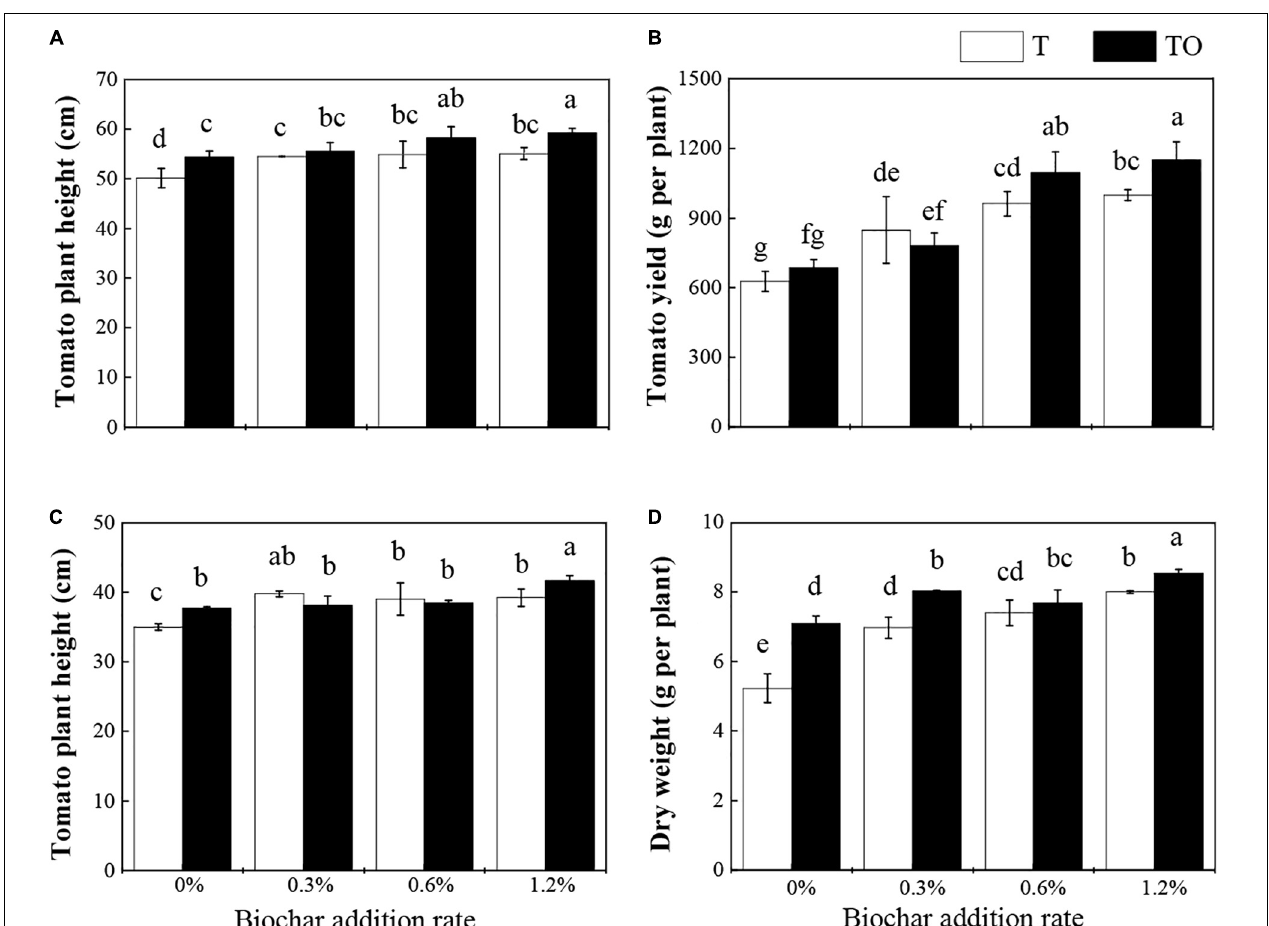
FIGURE 1 | Effects of biochar and intercropping on tomato height (A) and yield (B) in 2018, tomato height (C) and dry weight (D) in 2019. Tomato monoculture (T) and tomato/potato–onion intercropping (TO) indicate tomato monoculture and intercropped with potato–onion, respectively. 0, 0.3, 0.6, and 1.2% indicate the biochar rates. Different letters indicate the significant differences ( P <